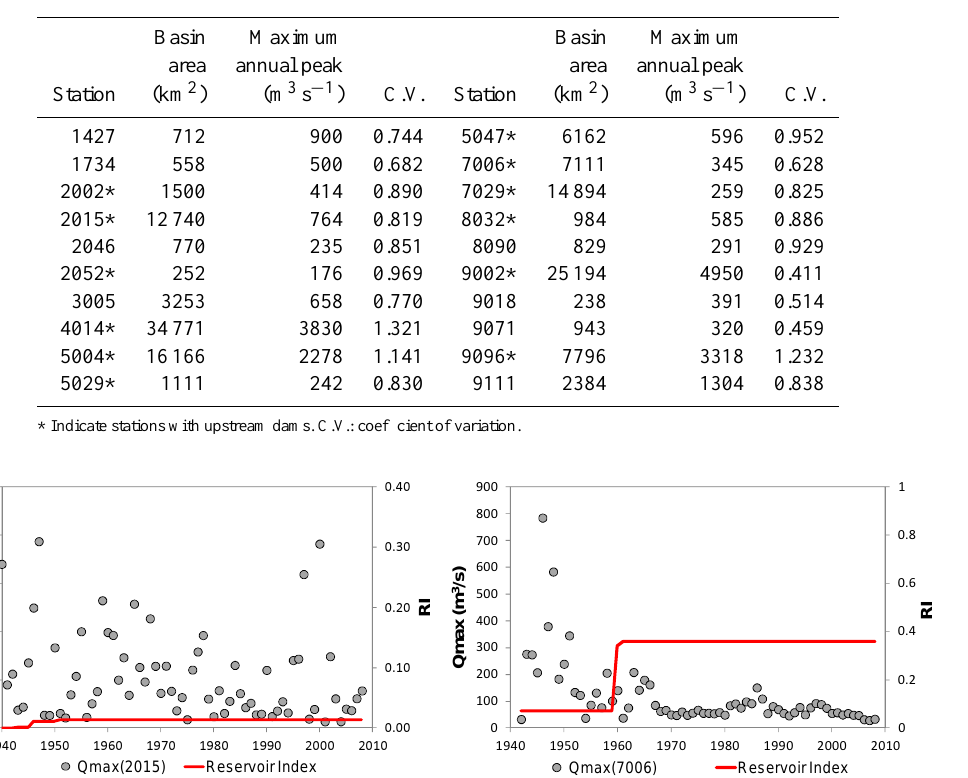
Table 1. Main characteristics of the analysed flow gauge stations.